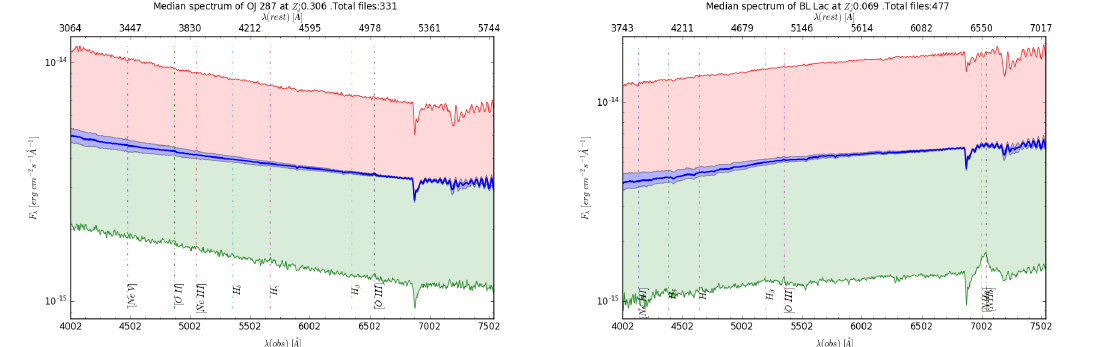
Figure 2. Median spectra computed for two BL Lac type objects: OJ 287 and BL Lac. Curves represent the same as in Figure